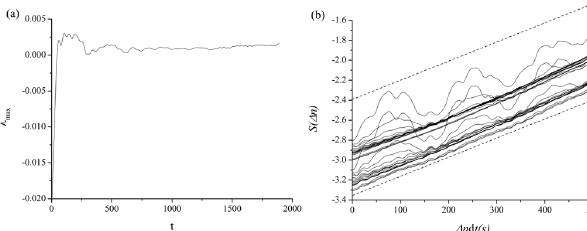
Fig. 11. Calculation of maximal Lyapunov exponent for the time series in Fig. 9. (a) indicates the value λ max = 0.0016, obtained by the method of (Wolf et al., 1985). The method of of (Rosenstein et al., 1993), illustrated in (b) , implies λ max ≈ 0.0019. Note that in (a) time t is expressed in the units of iteration steps. In (b) , effective expansion rate S(1n) represents the average of the logarithm of D i (1n) , defined as the average distance of all nearby trajectories to the reference trajectory as a function of the relative time 1n . The slope of dashed lines indicating the predominant slope of S(1n) in dependence on 1n d t presents a robust estimate for the maximal Lyapunov exponent. The results are determined for 1000 reference points and neighbouring distance ε = 0.1–0.15. The obtained values of maximal Lyapunov exponent are of the same order of